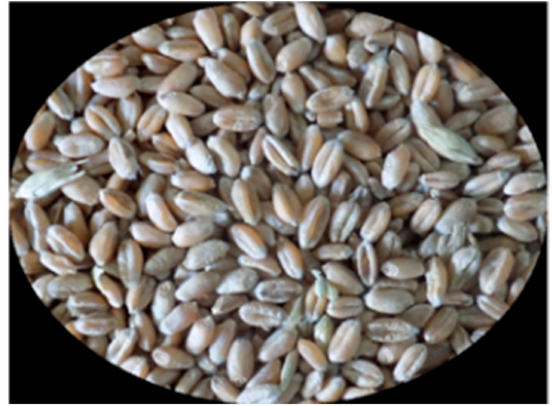
Figure 4. Image before segmentation [own